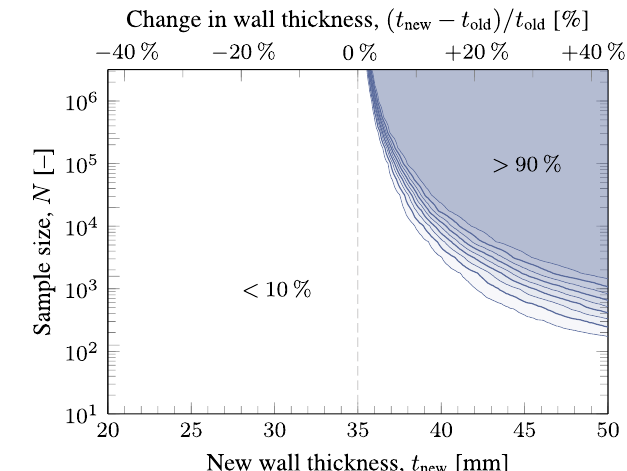
Figure 12. Relative number of times a new wall thickness is ac- cepted on the basis of a 50-year stress level, predicted with a fitting- before-aggregation approach with a Gumbel fitted above a thresh- old.